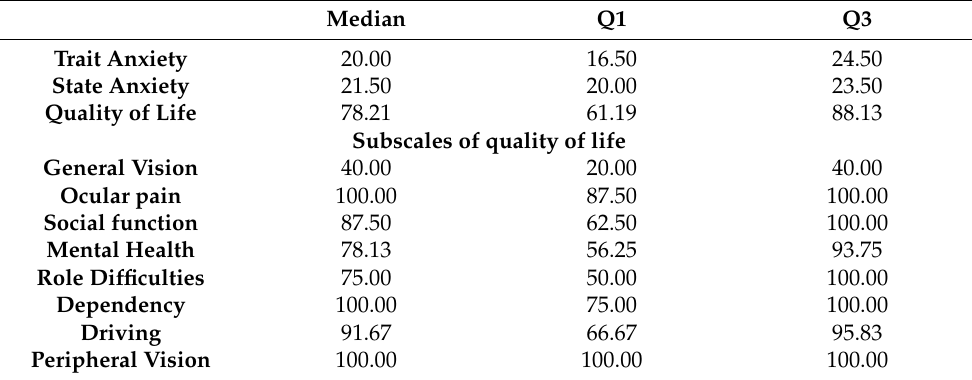
Table 1. Median values of STAI—quality of life in general and in the different subscales in patients